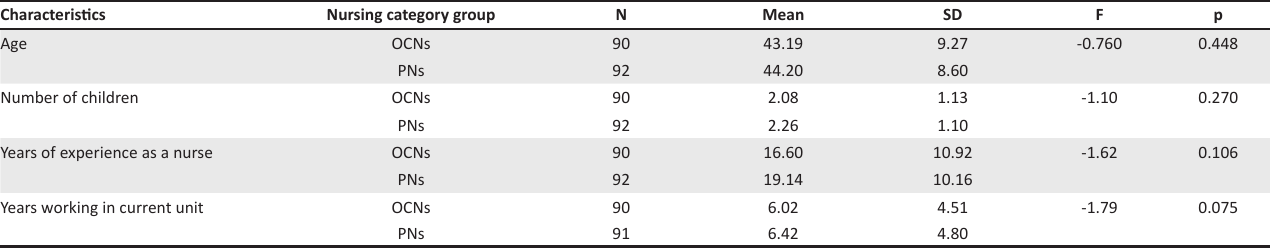
TABLE 2: Comparison of demographic and professional characteristics of PNs and OCNs using the analysis of variance ( n = 182). Characteristics